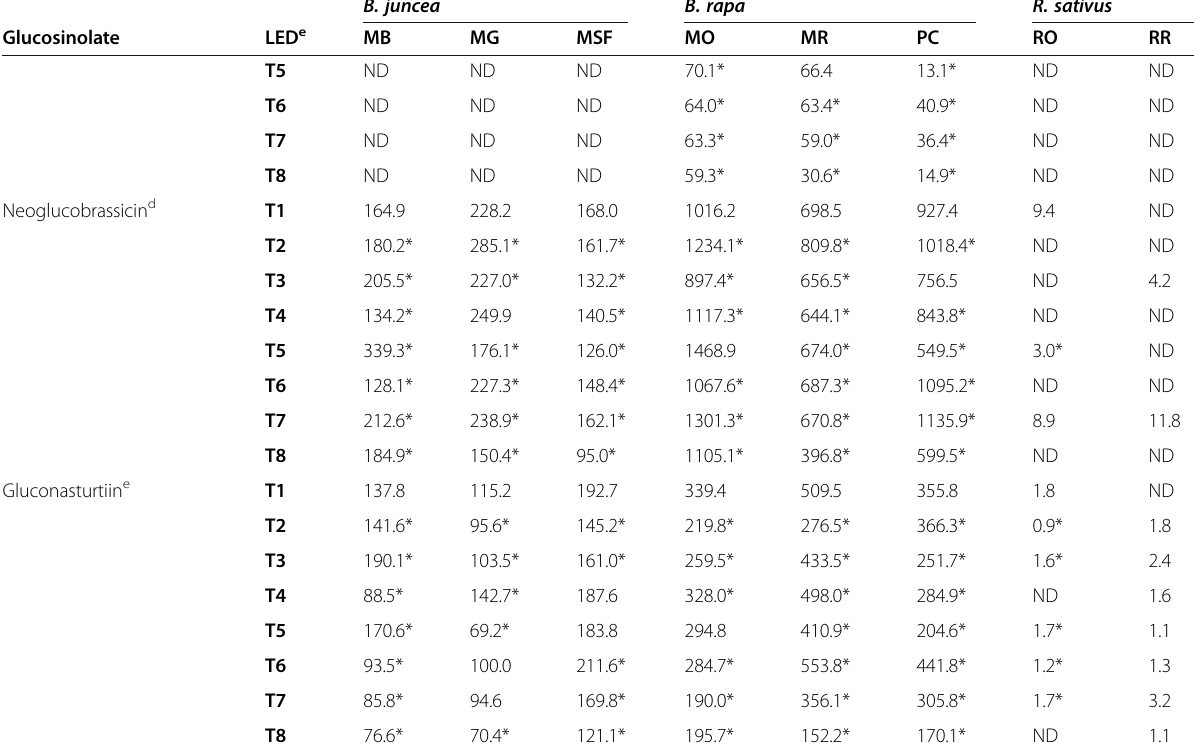
Table 3 Concentration of the glucosinolates identified in the microgreens under combined red, blue and amber LED. a Values are expressed as μ g sinigrin b , glucobrassicin c or gluconasturtiin d equivalents per g of microgreens (dry weight)